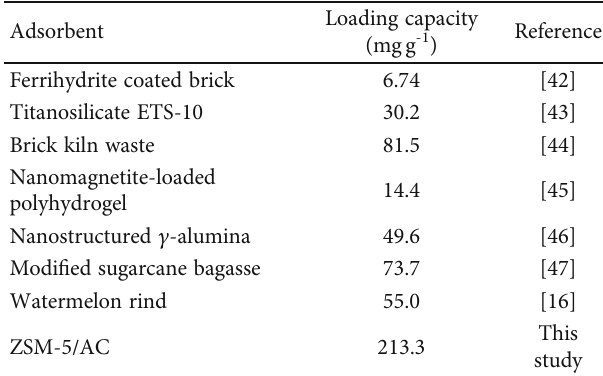
Table 5: Comparison of loading capacity of various adsorbents towards Pb 2+ ions reported in